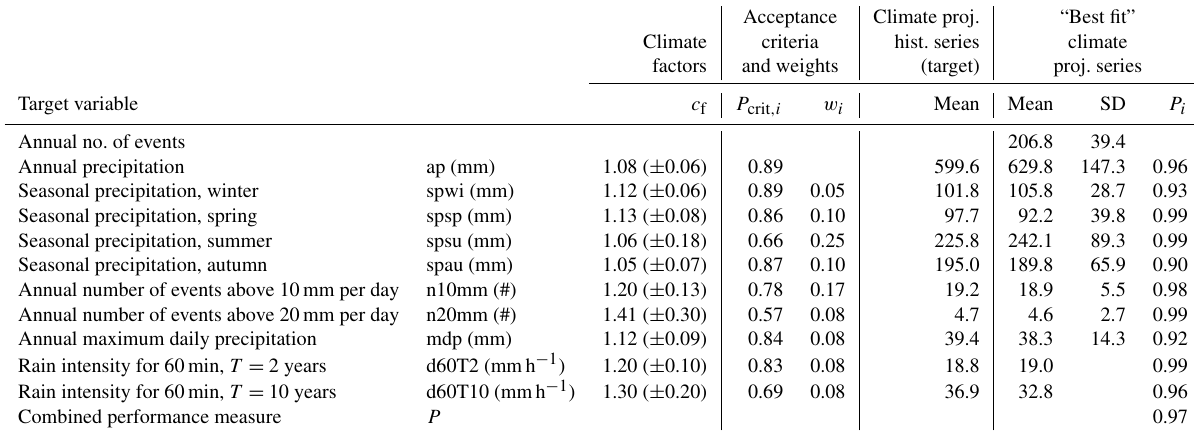
Table 6. Climate factors of target variables and minimum acceptance criteria of the individual performance parameters Pi,j , empirical combined performance measure weights ( w i ) , climate-projected target variables, and the corresponding values ( ± standard deviation) of the best-fit climate-projected